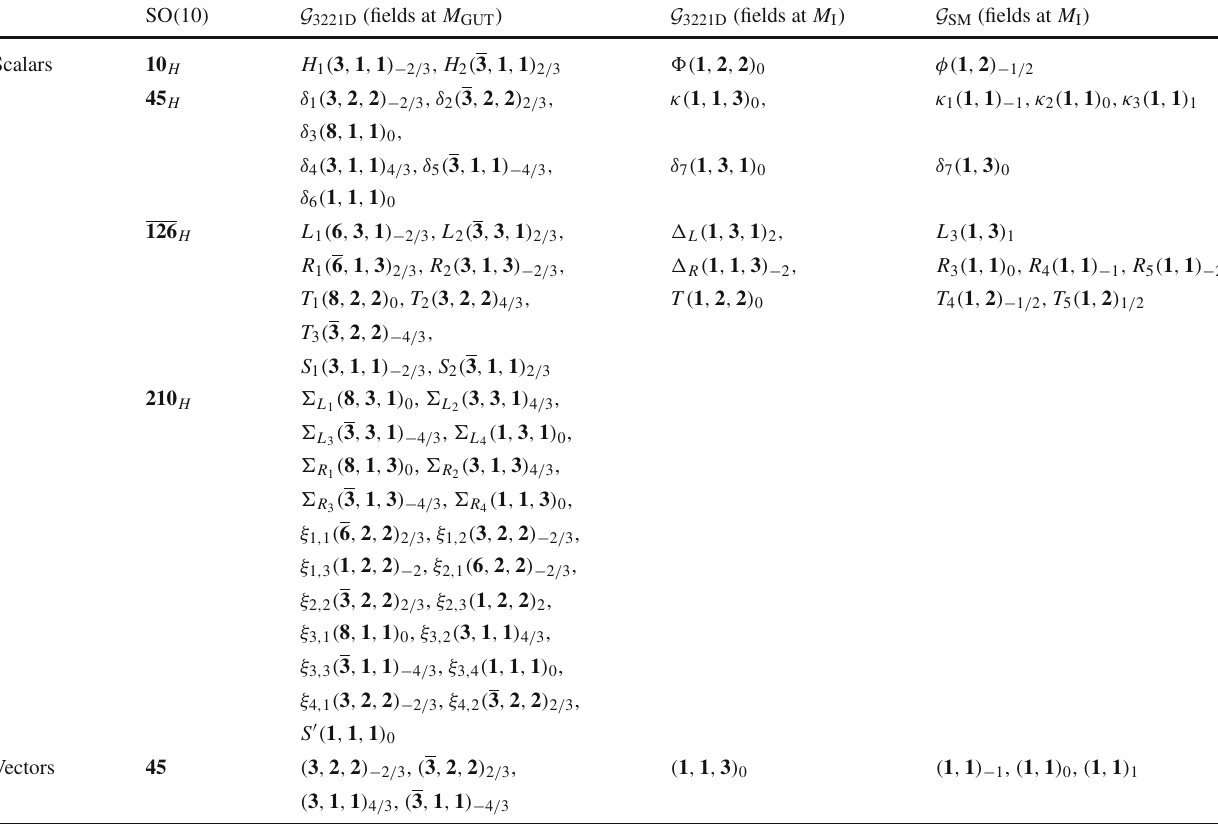
Table 8 Scalar and vector fields that have masses around M GUT and M I in the G 3221D model SO ( 10